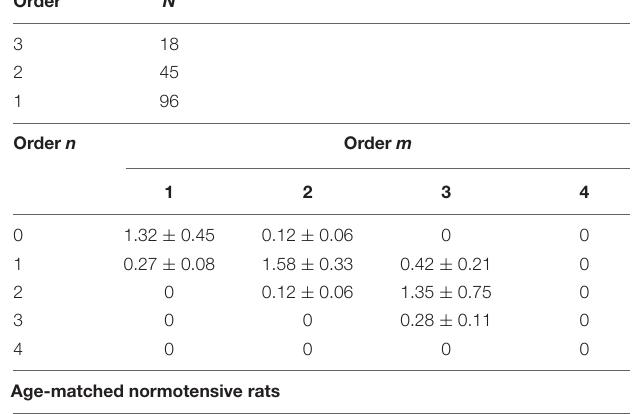
TABLE 5 | Connectivity matrix of the pial arterioles in adult SHR (C) and in age-matched normotensive rats (D). Adult spontaneously hypertensive